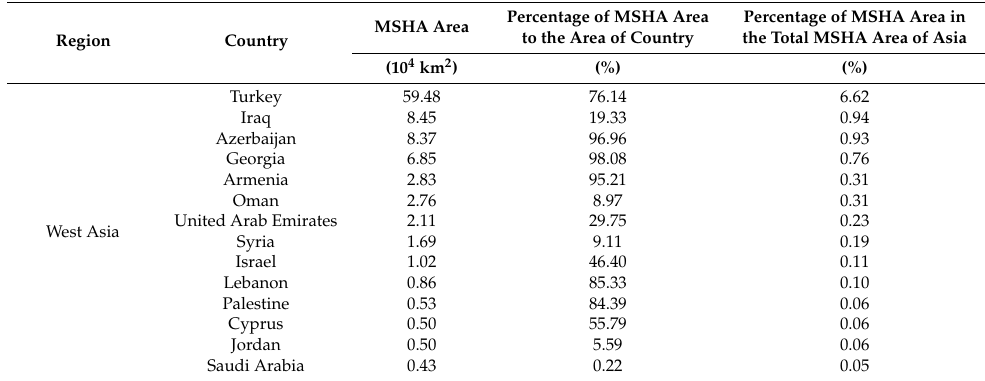
Table A1. The areas of the MSHA in each country. Percentage of MSHA Area MSHA Area to the Area of Region Country